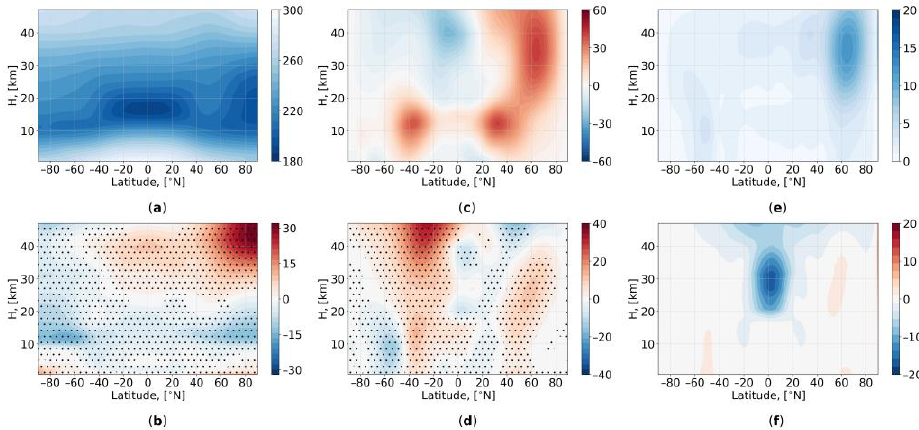
Figure 2. Winter (December – February) zonal mean temperature [K], ( a ), zonal wind [m/s], ( c ) and standard deviation of the zonal wind [m/s] ( e ) according to the control experiment and their differ- ence with the winter (December – February) zonal mean temperature [K], ( b ), zonal wind [m/s], and ( d ) standard deviation of the zonal wind [m/s] ( f ) according to the reanalysis data JRA-55. The av- erage values of the control experiment were calculated for 100 years, and for the JRA-55 reanalysis averaged period is [1958/59 – 2020/21]. Statistically significant differences at the 1% level ( b , d ) are marked with dots.